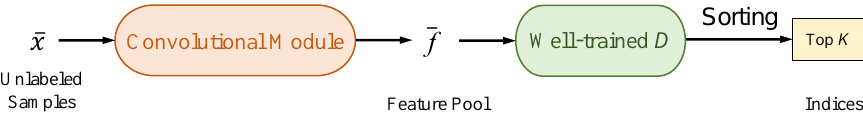
Figure 3. Active query of unlabeled samples. Both the convolutional module of the classifier and the well-trained feature discriminator D are frozen. We let unlabeled hyperspectral samples x input the convolutional module to obtain a pool of high-level features f . Following, we put those features into the well-trained D and sort them in the light of estimated probabilities. We query the top K minimums, with which we trace back to the corresponding hyperspectral samples and label them